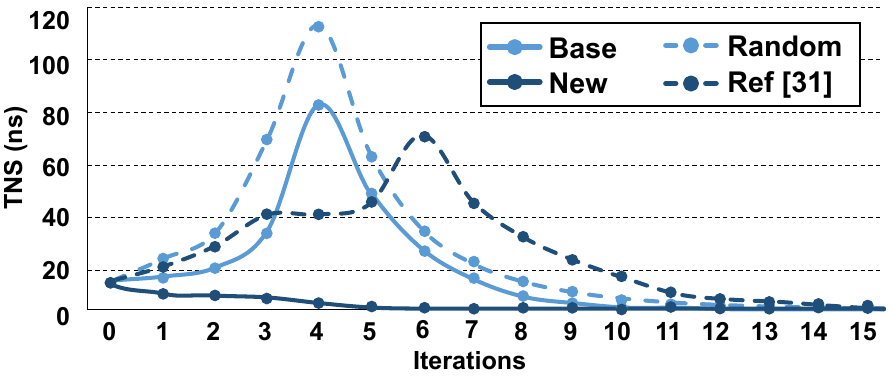
Figure 8. Progression of late TNS on des_perf_fast design using different LM initialization methods; initializing LMs to 1 (Base), using proposed method (New), initializing each LM to a random value (Random) and using initialization of [31] (Ref